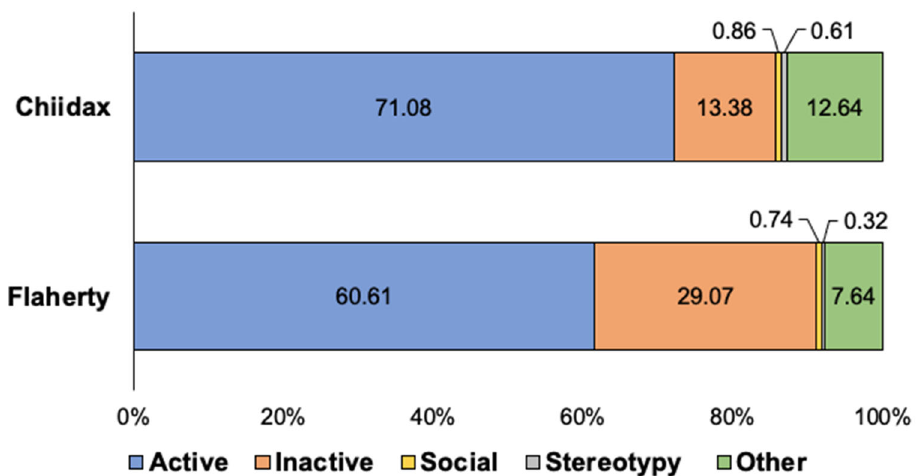
Figure 10. Average percentage of time that both of the northern fur seals spent engaging in each of the five classes of animal behavior (Active, Inactive, Social, Stereotypy, and Other) following the new introduction of Chiidax (post ‐ introduction). Note. As averages, the total count for each seal does not equal 100 percent (~98.38 ‐ 98.57%).